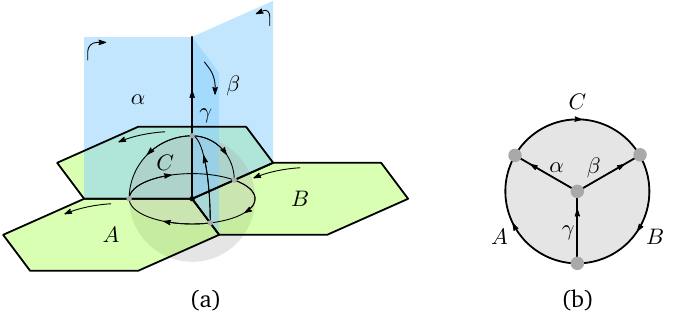
Figure 4: Application of the evaluation map on a vertex of the physical boundary (a) leads to a tetrahedral diagram (b) that upon evaluation yields the PEPS